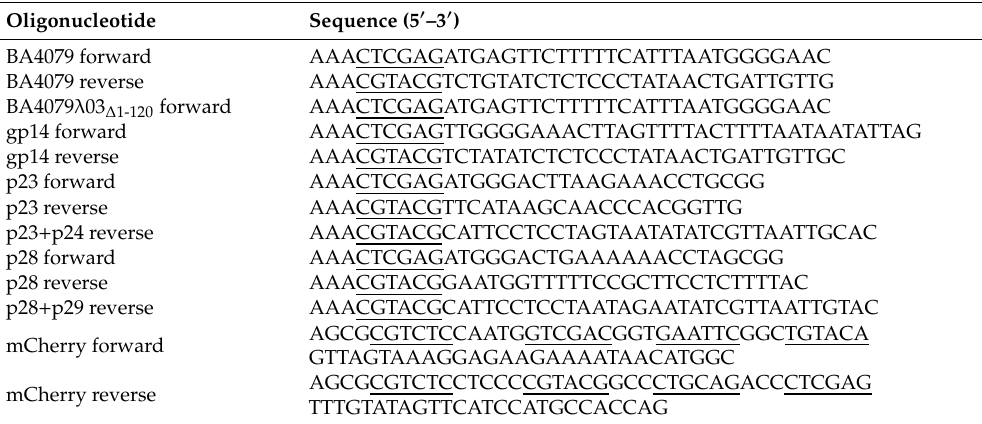
Table 1. Primers used for